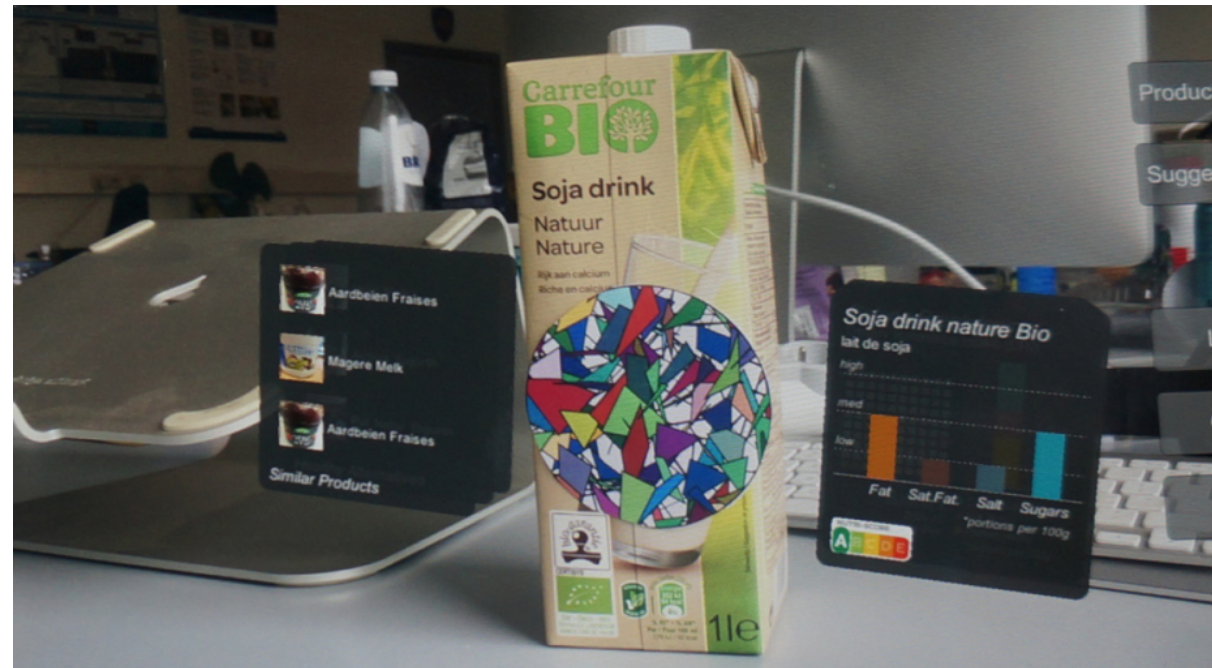
Figure 4. An example of the recommended healthy alternatives by Gutiérrez et